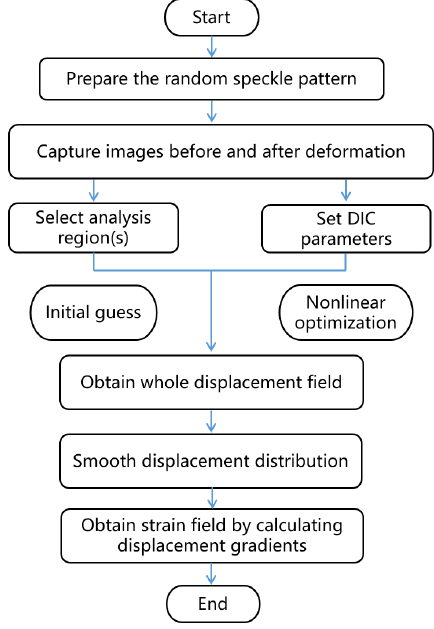
Figure 2. Flowchart of sea-ice image processing for the DIC